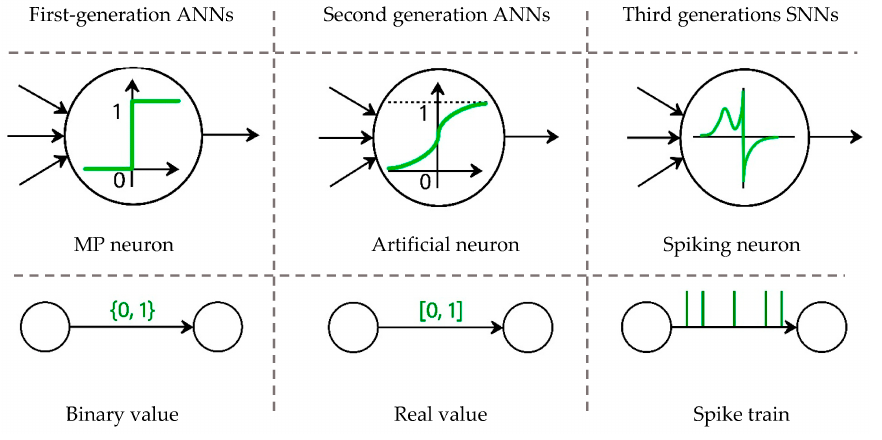
Figure 1. Three generations of ANNs: multilayer perceptron, McCulloch–Pitts neuron, and SNNs.